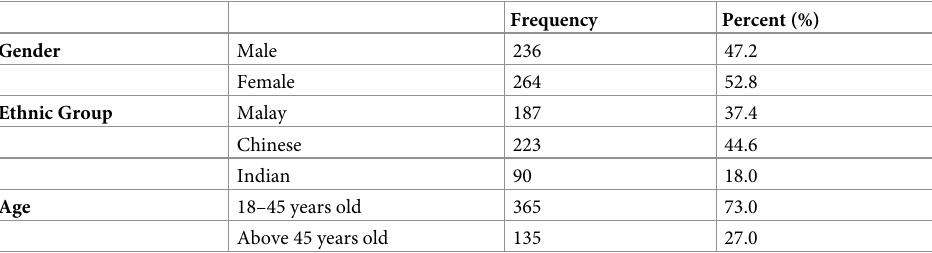
Table 1. Demographics of the